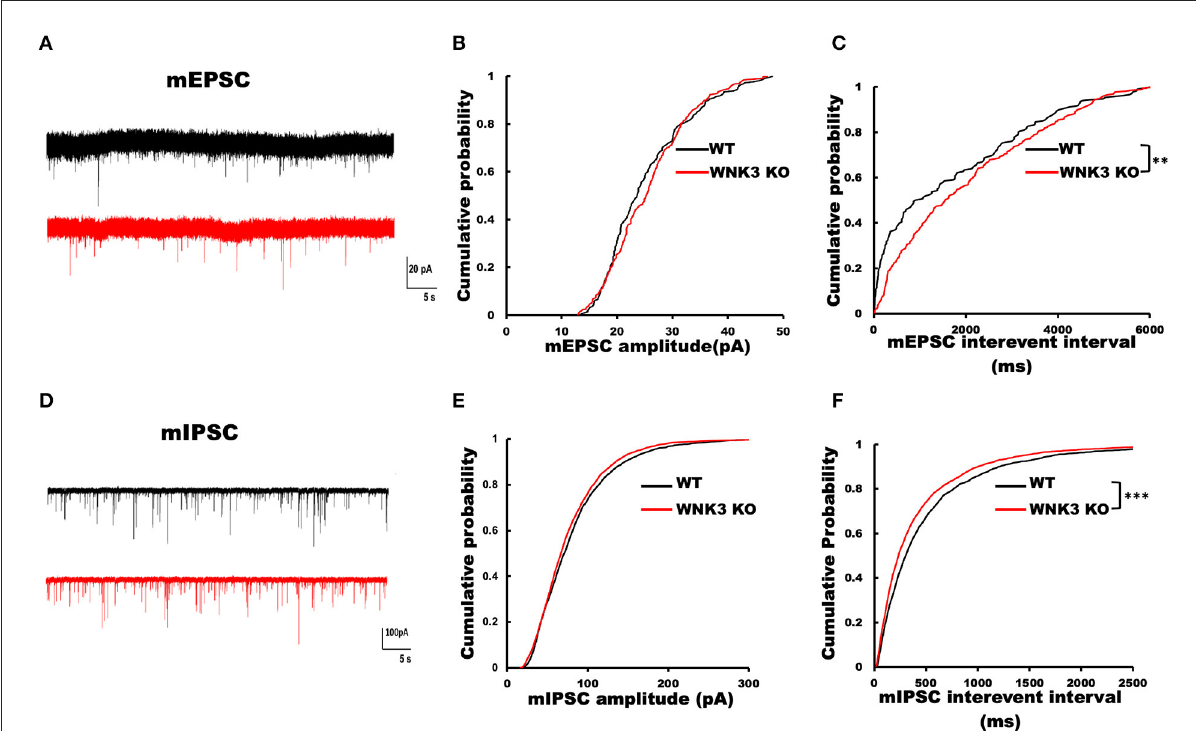
FIGURE8 Loss of WNK3 kinase leads to simultaneous reduction and increment of excitatory and inhibitory inputs, respectively, to layer V pyramidal neurons in the mPFC. (A) Representative mEPSC current traces recorded from layer V pyramidal neurons, WT (black) and WNK3 KO (red). Holding voltage was set at − 70mV with a CH 3 SO 3 K-based normal Cl − internal solution (see Methods section for composition). Scale bar as in figure inset (20pA, 5s). (B) Cumulative probability plot of amplitude distribution of mEPSC events. (C) Cumulative probability plot of interevent intervals (IEIs) of mEPSC events, indicating a reduction in the frequency of mEPSC recorded from WNK3 KO neurons ( N = 24 cells; K-S test, ** P < 0.01). (D) Representative mIPSC current traces recorded from layer V pyramidal neurons, WT (black) and WNK3 KO (red). Holding voltage was set at − 70mV with a 150.0mM CsCl-based solution (see Methods section for composition). Scale bar as in figure inset (100pA, 5s). (E) Cumulative probability plot of the amplitude distribution of mIPSC events. (F) Cumulative probability plot of IEI of mIPSC events. Note the leftward shift of IEI cumulative distribution of mIPSC events recorded from WNK3 KO neurons clearly indicating an increase in mIPSC frequency ( N = 25 cells; K-S test , *** P < 0.001). Cumulative plots are color coded as WT (black) and WNK3 KO